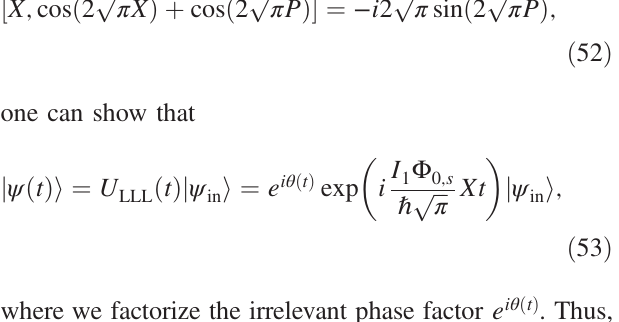
FIG. 11. Circuit implementation of the ideal logical a current source. Assuming the system starts in the code sub- space, the current source is turned on and kept constant at a value I 1 for a time t given in Eq. (54). A current source on the opposite Z port of the gyrator would instead implement a logical